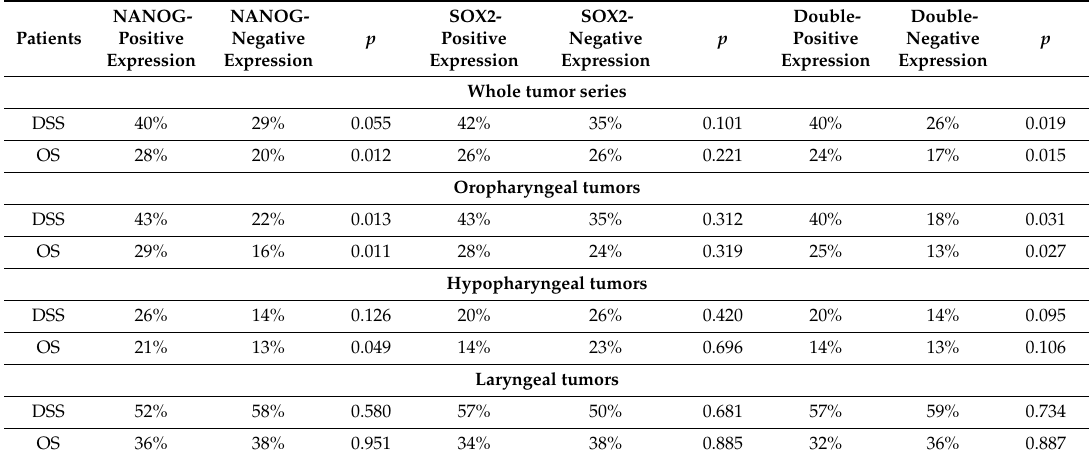
Table 3. Correlation between NANOG and SOX2 expression, and 5-year survival